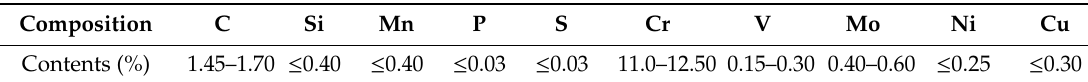
Table 2. Chemical composition table of Cr12MoV